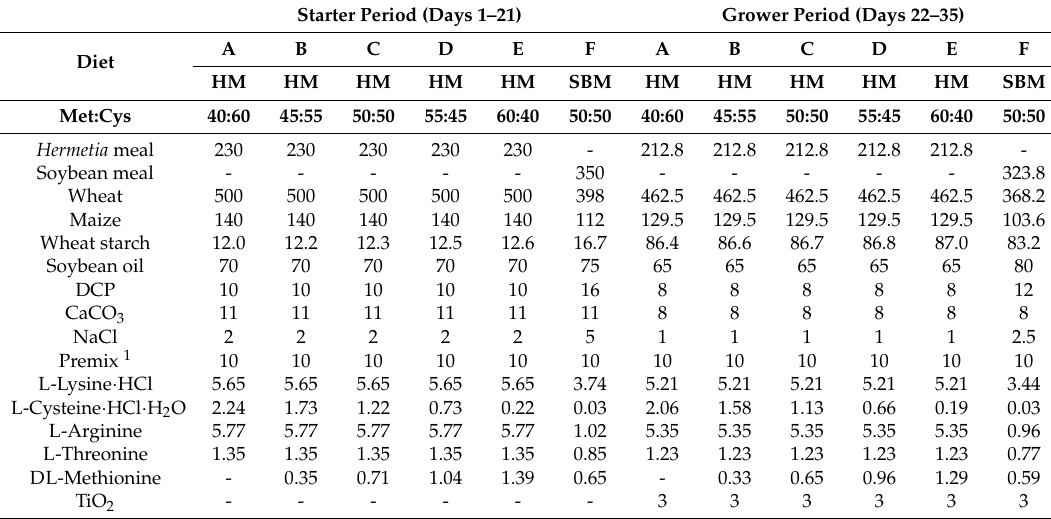
Table 2. Composition of the experimental diets (g/kg).